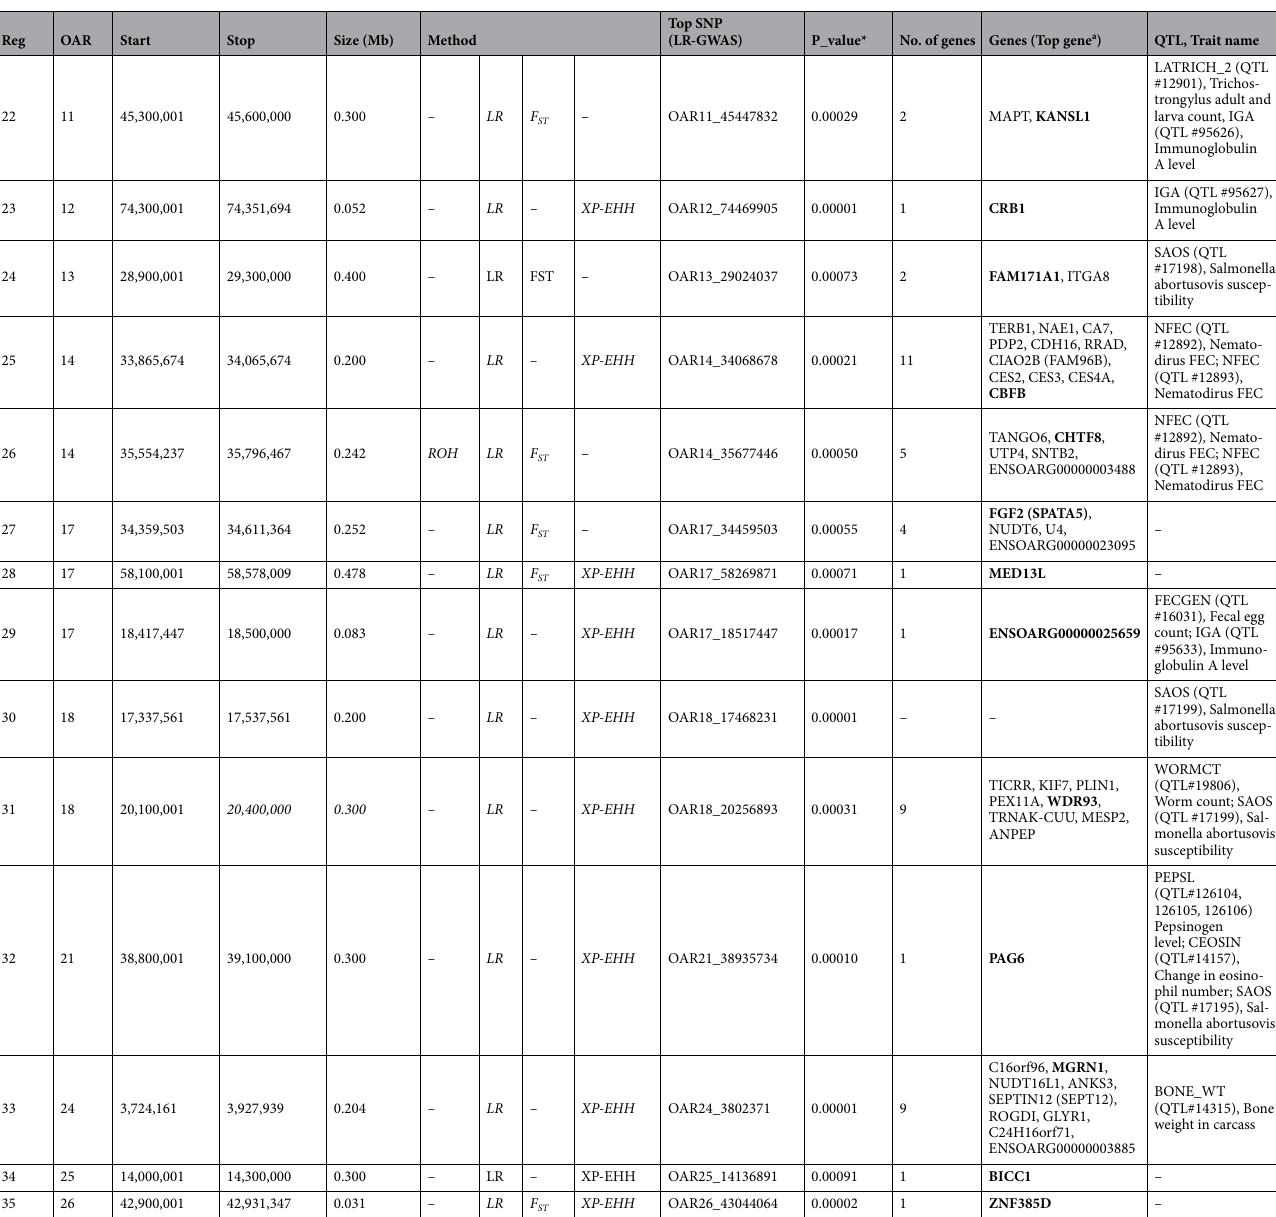
Table 4. Candidate regions, associated genes and QTLs that overlapped between at least two methods of detecting selection signatures. *Significant markers following LR-GWAS Bonferroni correction P < 0.001 a Top genes found close to the top-most significant SNP marker are shown in